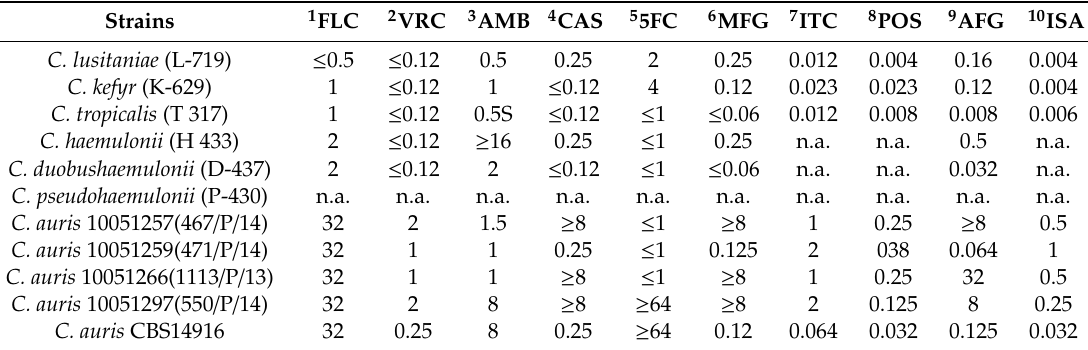
Table 1. Candida clinical strains used in this